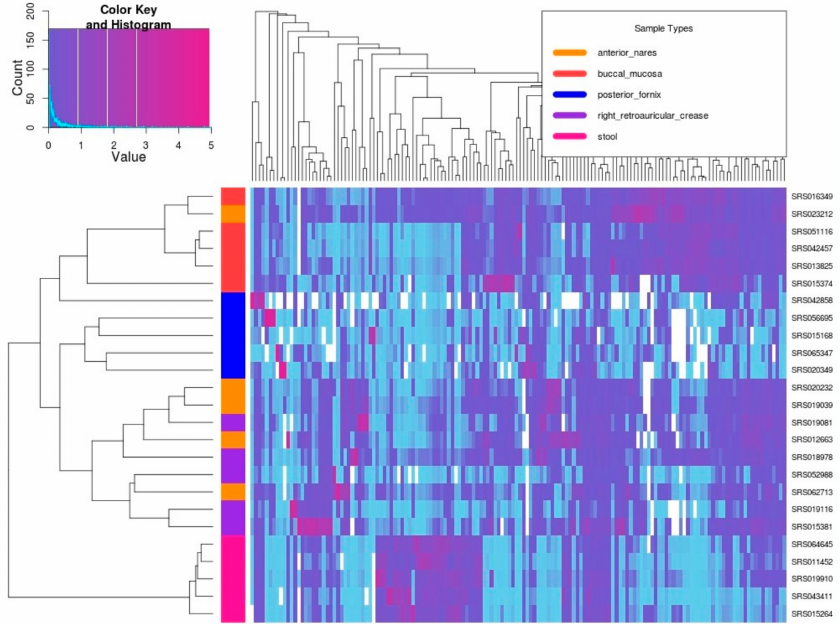
Figure 5. Thermal graph of microbial species relative abundance data in five different human tissues. The horizontal axis corresponds to the different microbial species, and the vertical axis corresponds to the metagenome samples of different human tissues. The white cells indicate that the microorganism corresponding to its vertical axis does not appear in the corresponding sample on the horizontal axis. The change in color from light blue to deep purple indicates that the relative abundance of microorganisms in the corresponding sample varies from low to high. The distance used by the cluster analysis of different metagenomic samples on the left side of the thermogram is derived from the Spearman correlation coefficient between the relative microbial abundance vectors (using the difference between unit 1 and the correlation coefficient as a